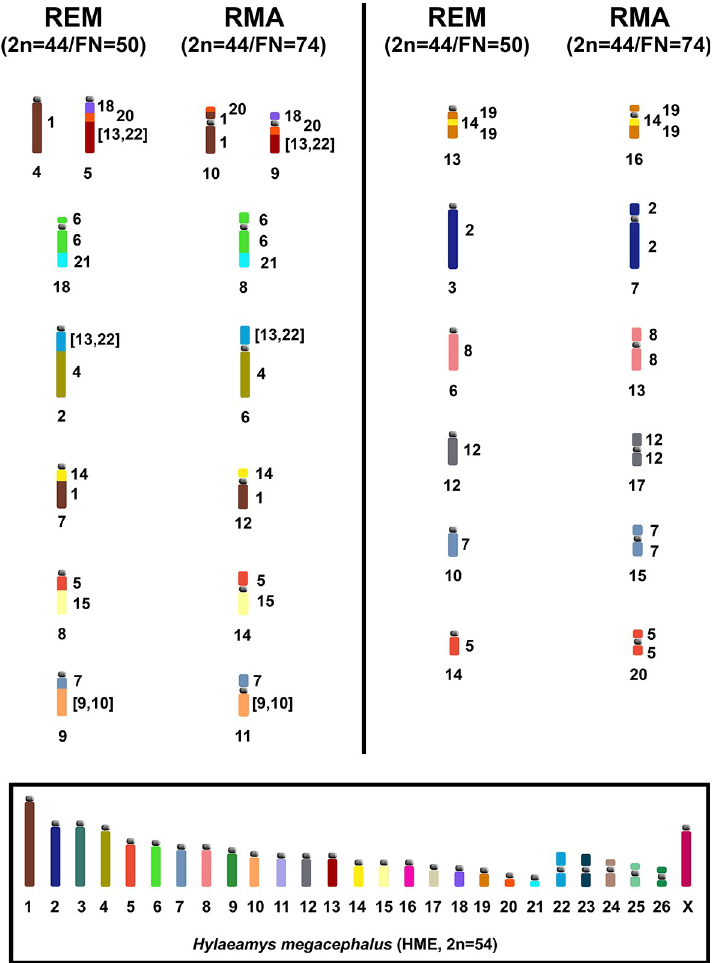
Fig 6. Idiograms of the haploid content of R . emiliae (REM; 2n = 44/FN = 50) and R . mastacalis (RMA; 2n = 44/ FN = 74), showing chromosomes involved in their karyotypic divergence, as assessed using HME probes [31]. HME probes are shown beside the idiograms, while each chromosomal pair is identified below. Idiograms within the box correspond to the H . megacephalus karyotype elaborated by Oliveira da Silva et al.